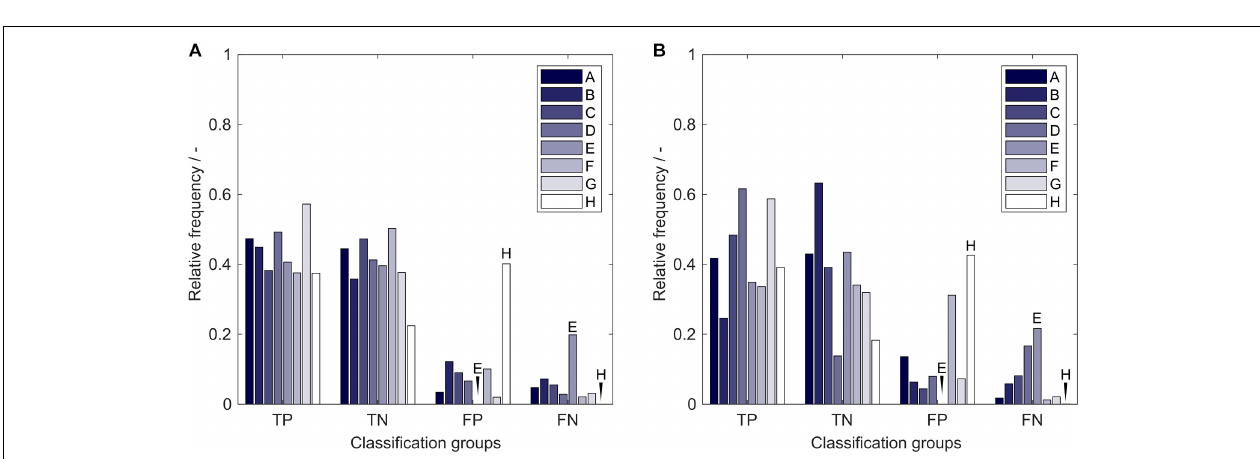
FIGURE 8 | Relative frequency of classification groups based on insertion strategies A-H in (A) the training set and (B) the external test set of the 17,920 models in the learning experiment. Strategy E and H are marked additionally to guide the eye. TP, true positive; TN, true negative; FP, false positive; FN, false